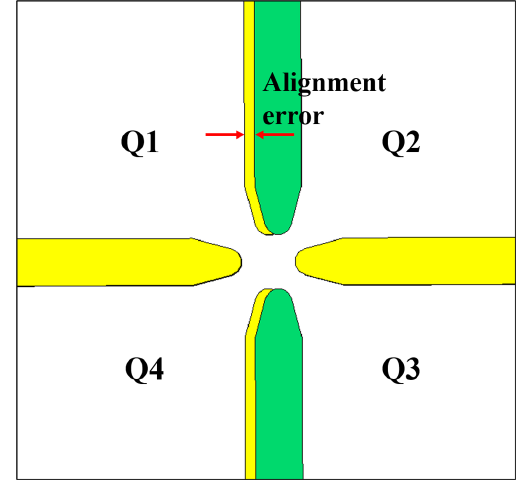
FIG. 7. Diagram of alignment error of four-vane RFQ vanes (yellow: ideal position of vanes, perfect symmetry; green: shifted position of vanes. Q1: first quadrant; and so